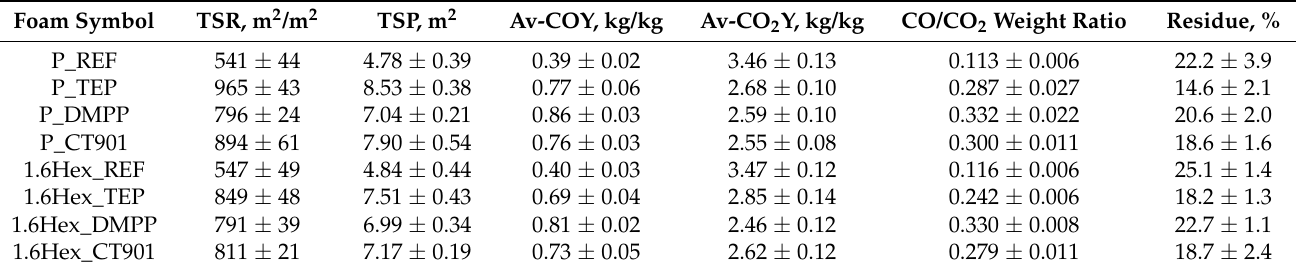
Table 7. Smoke emission behaviors and residue of polyurethane